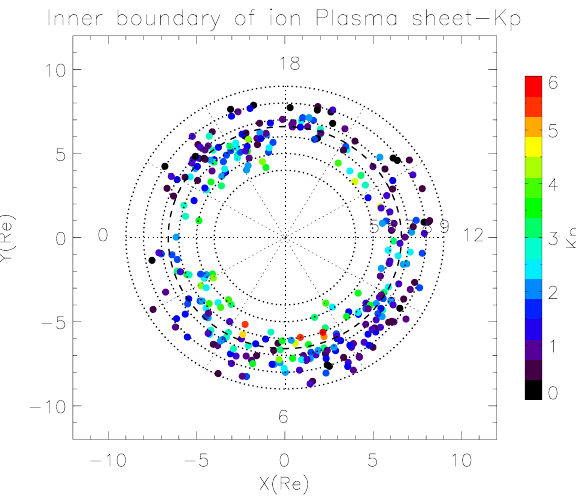
Fig. 2. The scatter plot of inner boundary of ion plasma sheet de- tected by TC-1 in the X-Y GSM plane color-coded according to Kp